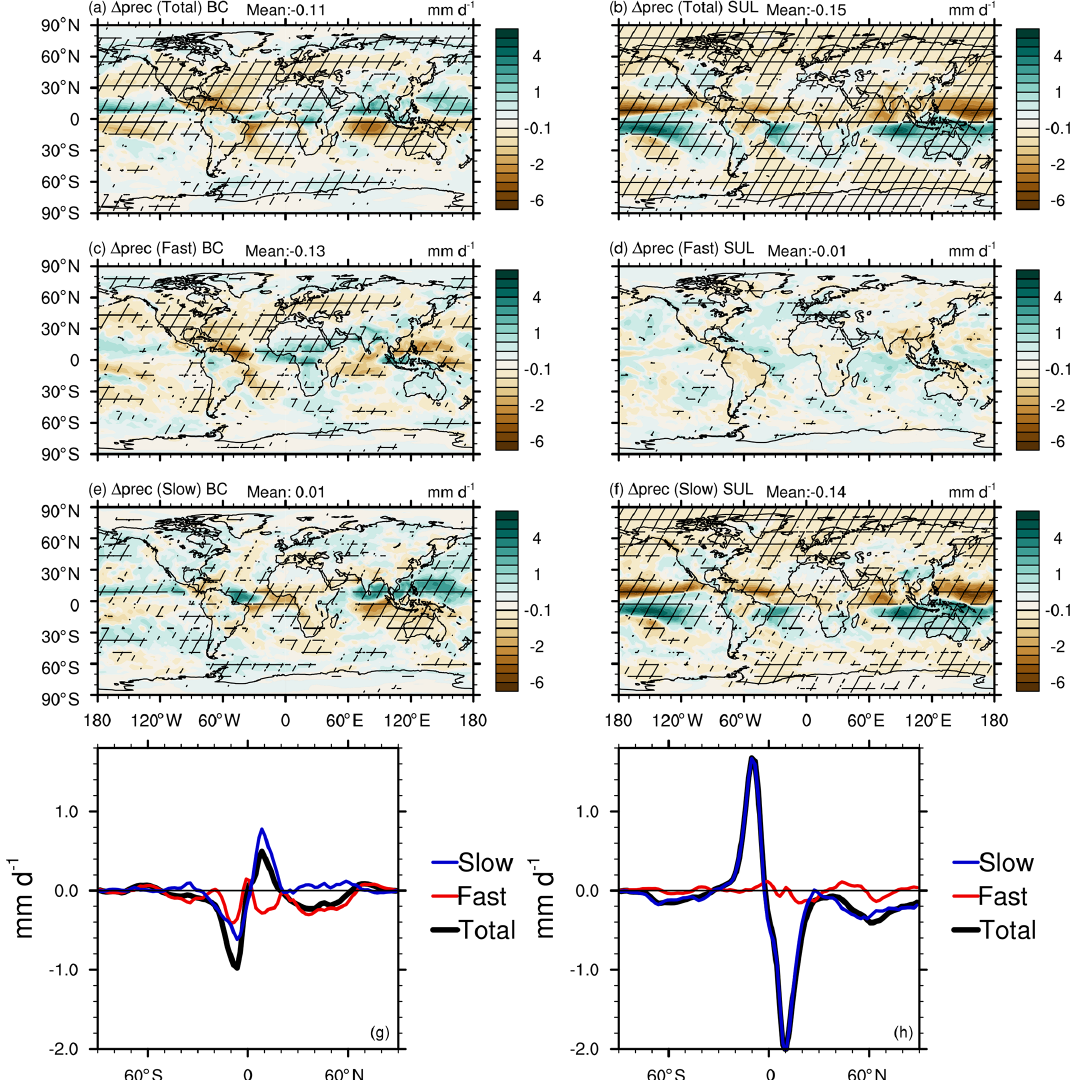
Figure 1. ECHAM6–HAM2 simulated geographical patterns of multi-annual mean precipitation change in response to 10-fold increased (a, c, e) BC emissions and (b, d, f) 5-fold increased SUL precursor emissions for (a, b) total, (c, d) fast, and (e, f) slow responses. Hatching indicates where the changes are significant (90% confidence). (g, h) Zonal averages of changes in precipitation in terms of total, fast, and slow responses to 10-fold increased (g) BC emission and (h) 5-fold increased SUL